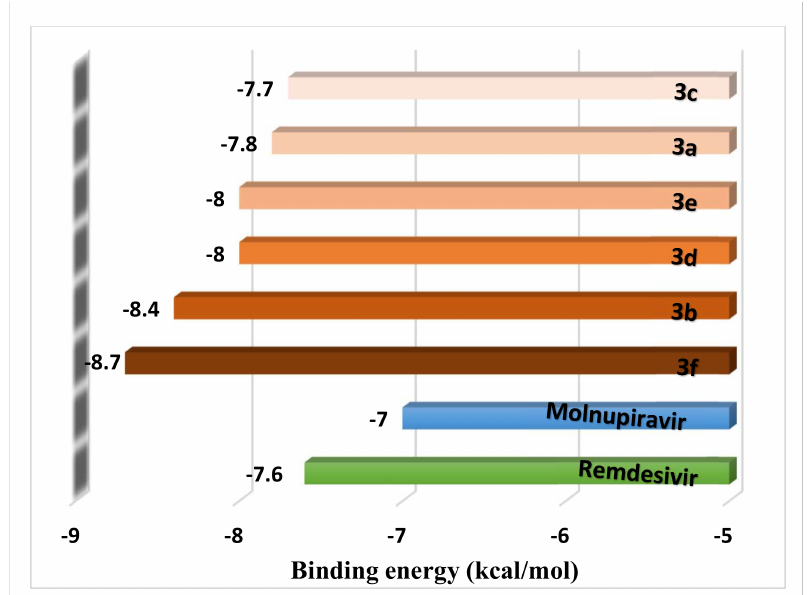
Figure 3. Binding affinities of compounds 3a–f against the COVID-19 protease 7BQY and the approved medicines for a comparison.